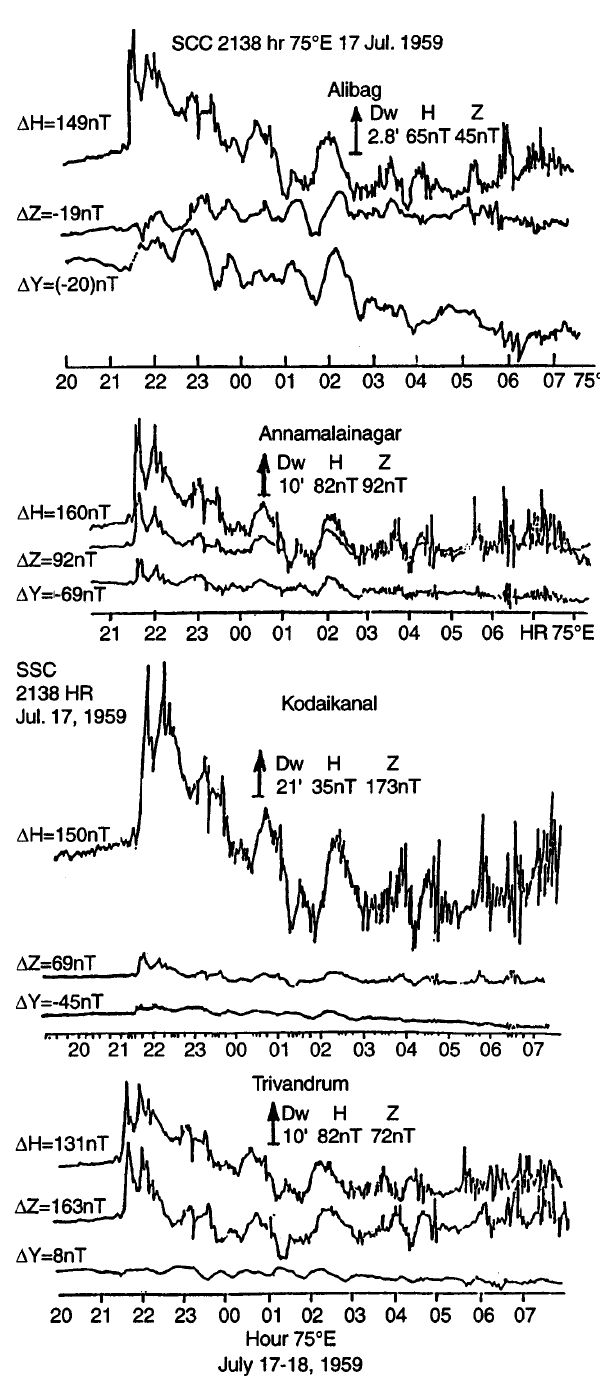
Fig. 2. Tracings of H, Y and Z magnetograms at Trivandrum, Kodaikanal and Annamalainagar during SSC at 2138 LT (night-time) on July 17,